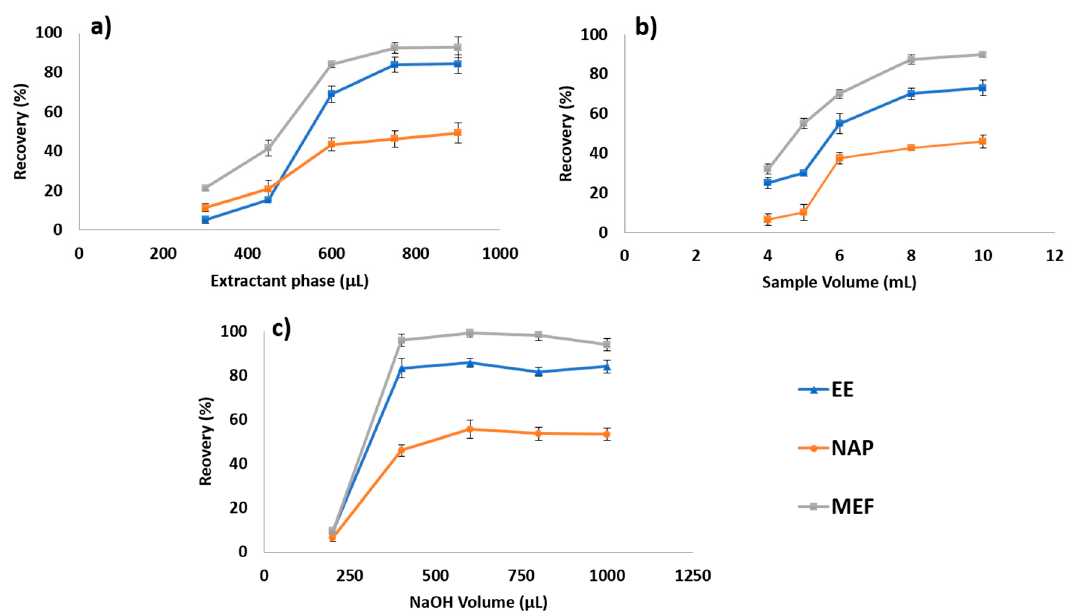
Figure 2. Effect of the extractant phase volume (50:50 SHS:Water) ( a ); sample volume ( b ) and NaOH as phase separation ( c ) trigger on the extraction recovery for a standard solution containing the model analytes at 500 ng L − 1 .